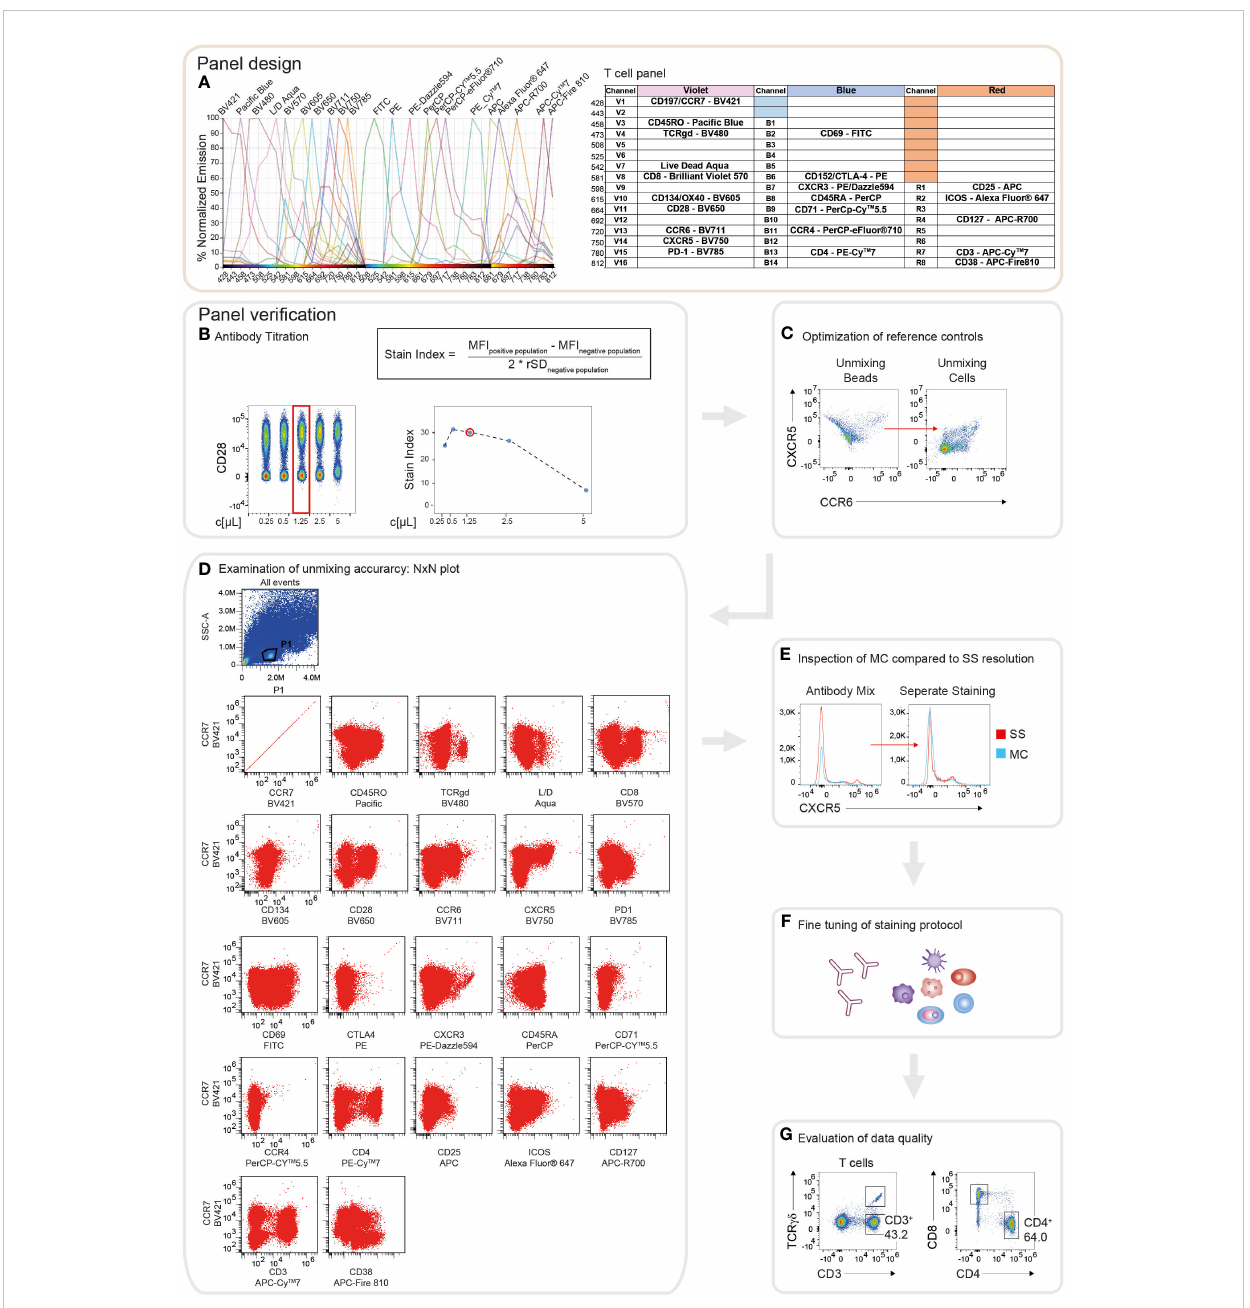
FIGURE 1 Schematic illustration of the work fl ow for panel design and veri fi cation. (A) Theoretical panel design of the T cell immunophenotyping panel. Readout of the Cytek Full Spectrum Viewer (Cytek Biosciences) displaying the spectral signatures of the 22 fl uorophores in the 3L con fi guration of the Cytek Aurora (left). Optical layout of the used markers and fl uorophores showing the approximate peak emission wavelengths (nm) (right). (B) Overview of the veri fi cation strategy for the T cell immunophenotyping panel. Representative example of the antibody titration depicting CD28 conjugated to BV650. Left: Pseudo-color plot of the concatenated fi les of the 1:2 serial dilutions of CD28. On the x-axis, the respective concentration is shown as µl/test. The red box indicates the fi nal titration result. Right top: The Stain Index (SI) is calculated as the difference between the median fl uorescence intensity (MFI) of the positive and negative populations, divided by two times the robust standard deviation (rSD) of the negative population. MFI and rSD were extracted from FlowJo in.csv fi le format. Right bottom: Diagram depicting the calculated SI of CD28- BV650 over 1:2 serial dilution steps. The x-axis displays the respective concentration as µl/test. The red circle indicates the fi nal titration result. (C) Dot plots showing an exemplary illustration of “ unmixing ” accuracy of CXCR5-BV750 and CCR6-BV711 utilizing single stained compensation beads compared to single stained whole PBMCs. (D) NxN plots depicting the quality control of “ unmixing ” accuracy in the multi-color stained sample, gated on lymphocytes. CCR7-BV421 is shown as a representative example of correct “ unmixing ” . In every NxN plot, CCR7 is represented on the y-axis and all other fl uorophores of the panel on the x-axis. (E) Staining resolution of the single stained (SS) tube compared to the fully stained/ multi-color (MC) tube on the example of CXCR5-BV750. (F) Loss of staining resolution resulted in fi ne-tuning of the staining protocol, such as separate staining steps and changes in the antibody concentrations. (G) Immunophenotyping results were manually gated and compared to published studies to evaluate the quality of the